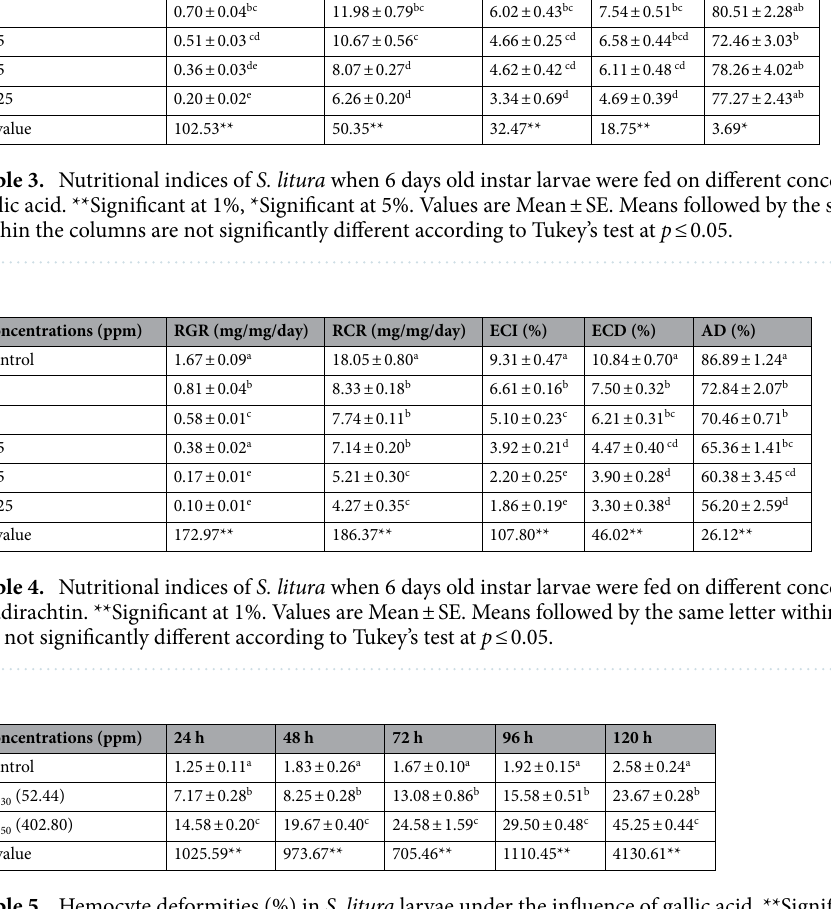
Table 5. Hemocyte deformities (%) in S. litura larvae under the influence of gallic acid. **Significant at 1%. Values are Mean ± SE. Means followed by different superscript letters within a column are significantly different ( p ≤ 0.05) based on Tukey’s